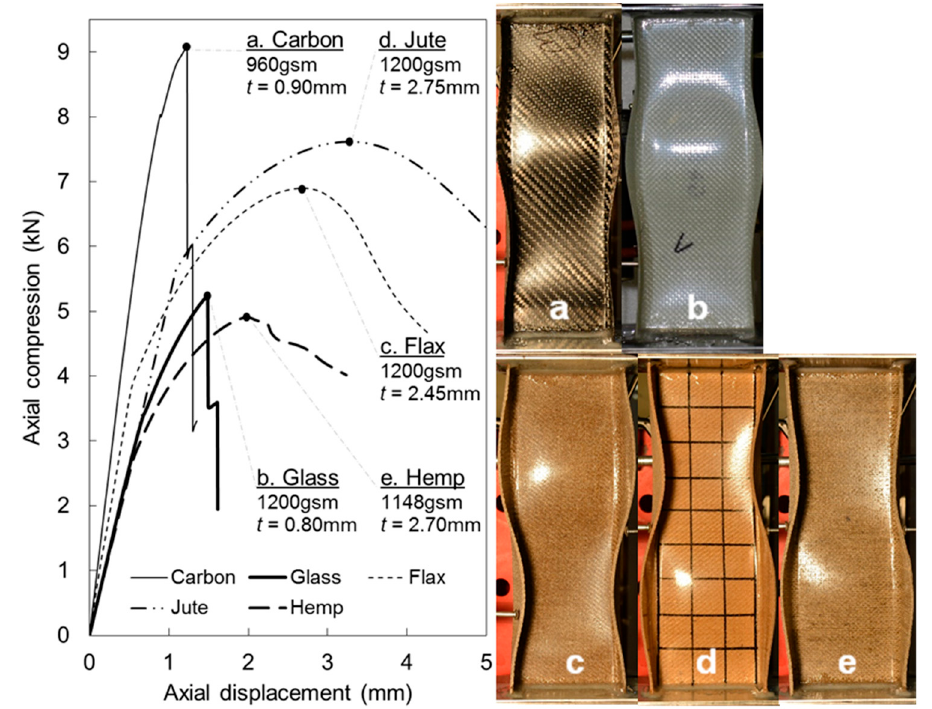
Figure 6. Exemplar composite channel compression tests for the approximately 1200 gsm total fiber areal mass comparator group (960–1200 gsm) (all column heights are 300 mm).